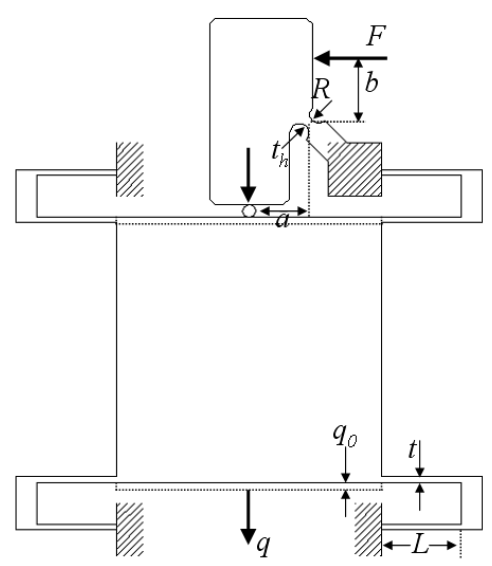
Figure 2 . A simplified model of the z